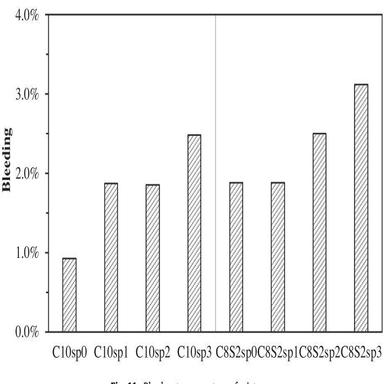
Bleed water percentage of mixtures.